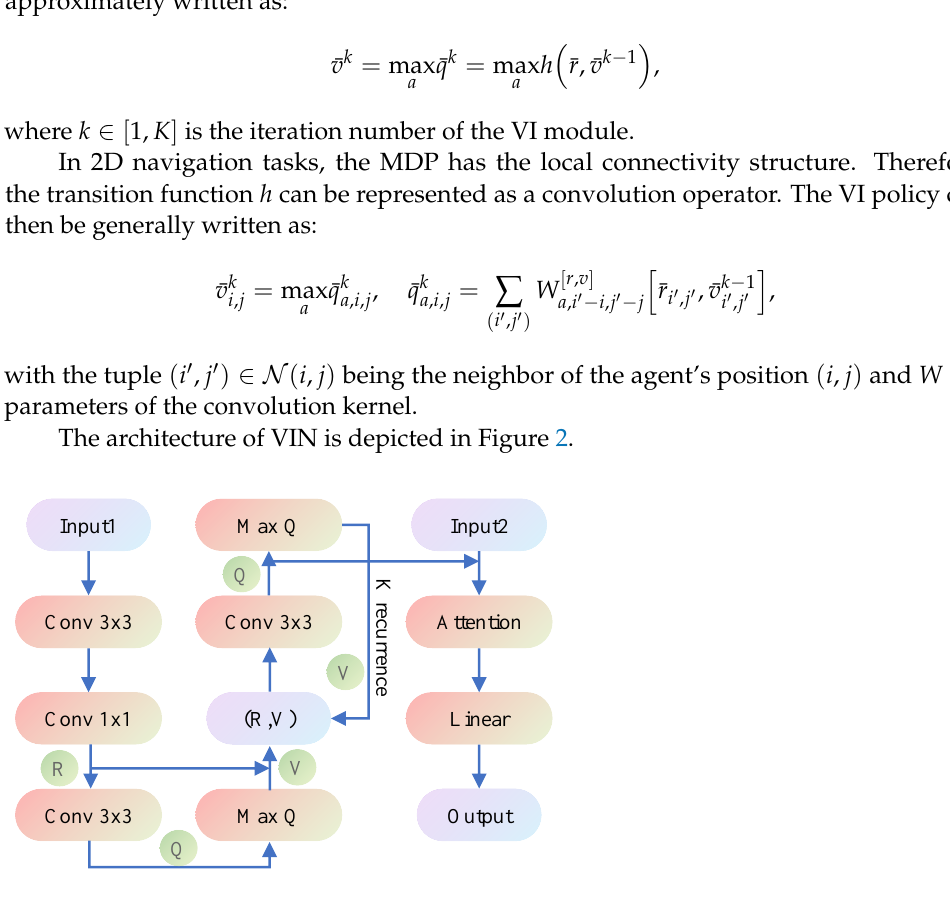
m n ) -sized image, where m and n represent Figure 2. Architecture of the VIN. Input1is a ( 2 × × the length and width of the domain, encoding the obstacle presence and goal position, respectively. Input2 is a tuple ( i , j ) of the current position. Output is the probability distribution over available actions. The attention module is given to improve performance, by reducing the effective number of parameters during learning. The recurrence K was chosen, in proportion to the domain size, to ensure that information can flow from the goal position to any other